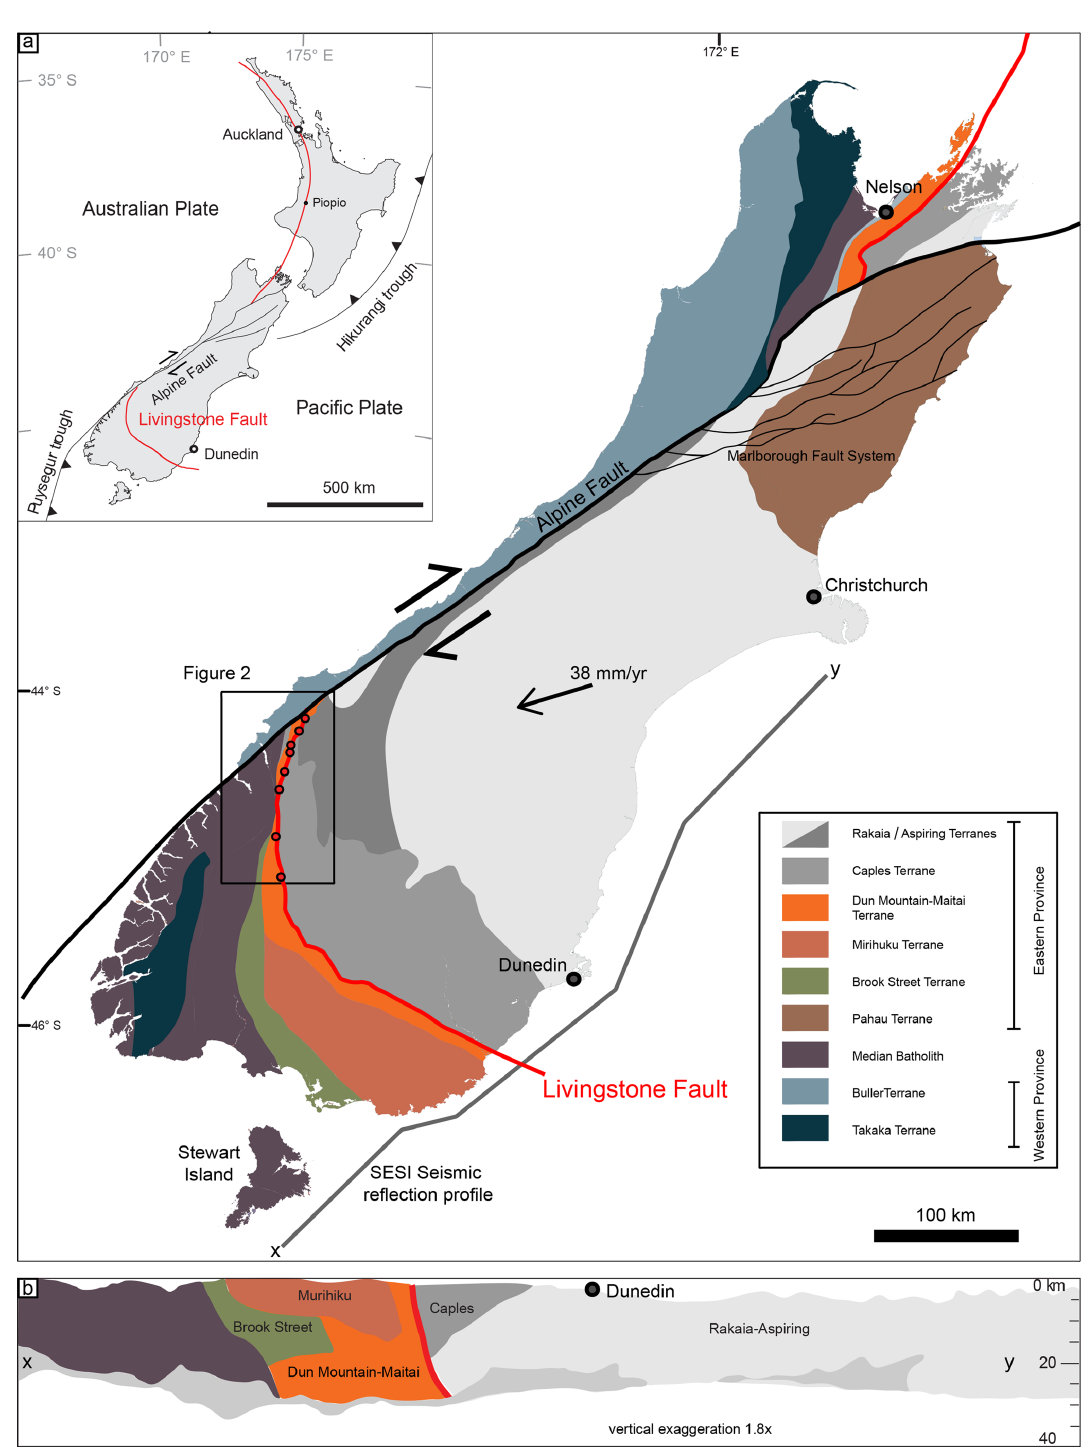
Figure 1. Regional geological setting. (a) Simplified regional map of the basement geology and tectonic setting of the South Island of New Zealand. Inset shows a map of New Zealand with present-day plate boundaries and the location of the Livingstone Fault in the North and South Island. Piopio (inset map) is the only exposure of the Dun Mountain Ophiolite Belt in the North Island of New Zealand (O’Brien and Rodgers, 1973). Modified from Cooper and Ireland (2015) with data from Mortimer (2004). (b) The regional-scale cross section along line x – y (shown in panel a ) is based on an interpretation of the composite southeast South Island (SESI) seismic reflection profile by Mortimer et al.